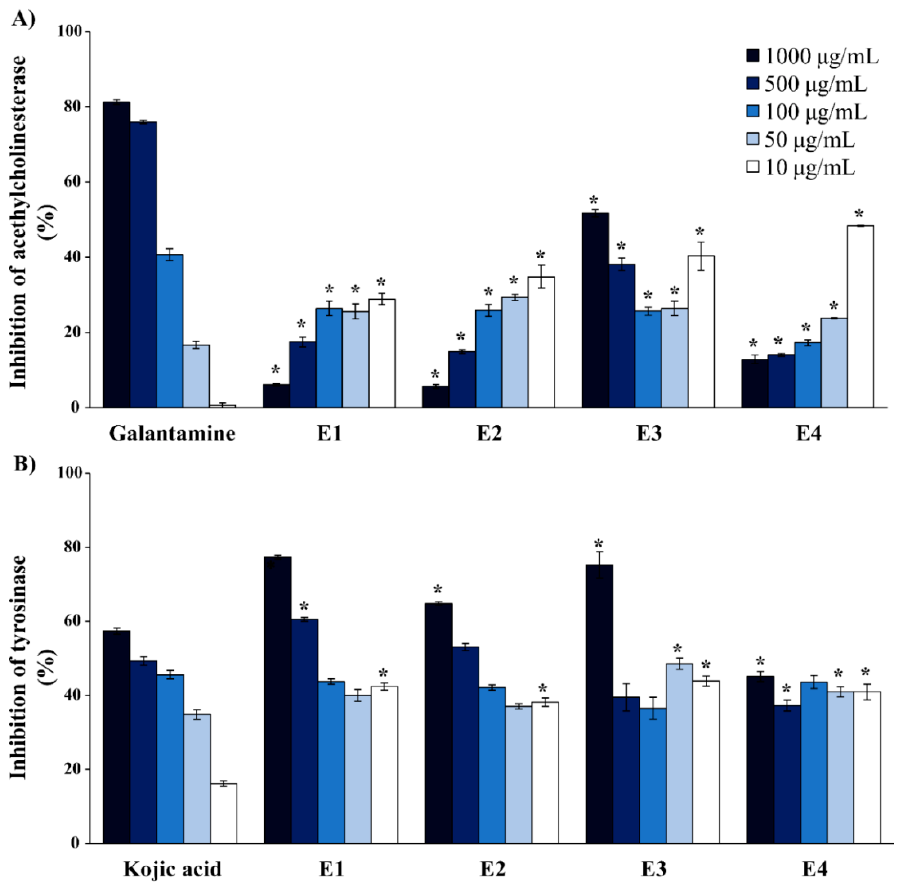
Figure 2. Biochemical analysis of Hypnum cupressiforme extracts as ( A ) antiacetylcholinesterase and ( B ) antityrosinase agents. The results are expressed as the mean ± standard error from an experiment performed in triplicate (* p < 0.05 different moss extracts vs. different standard substances).